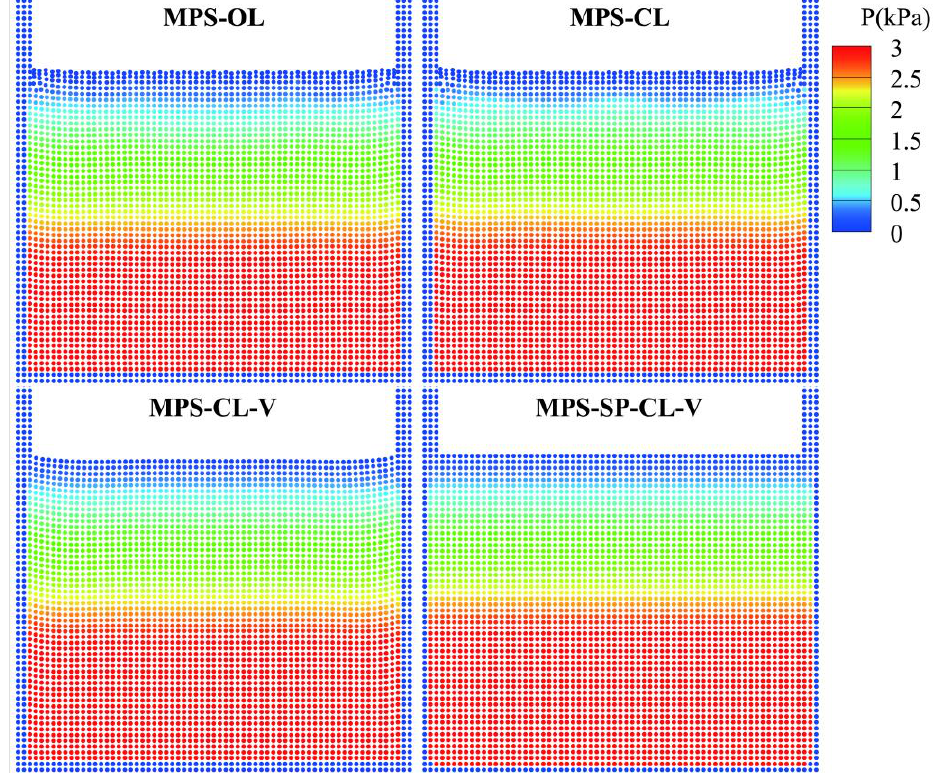
Figure 7. Fluid behavior of hydrostatic simulation in a regular tank using different models at t = 3.0 s.